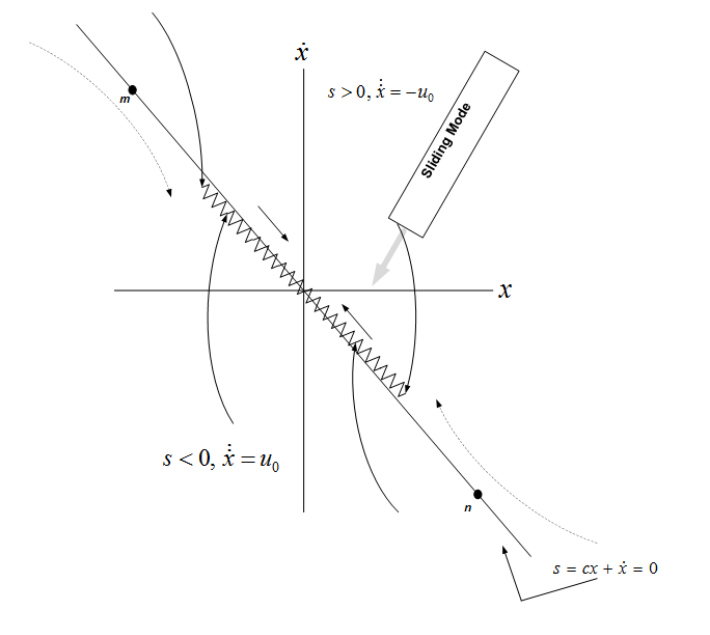
Figure 3. Working of sliding mode control, a graphical representation